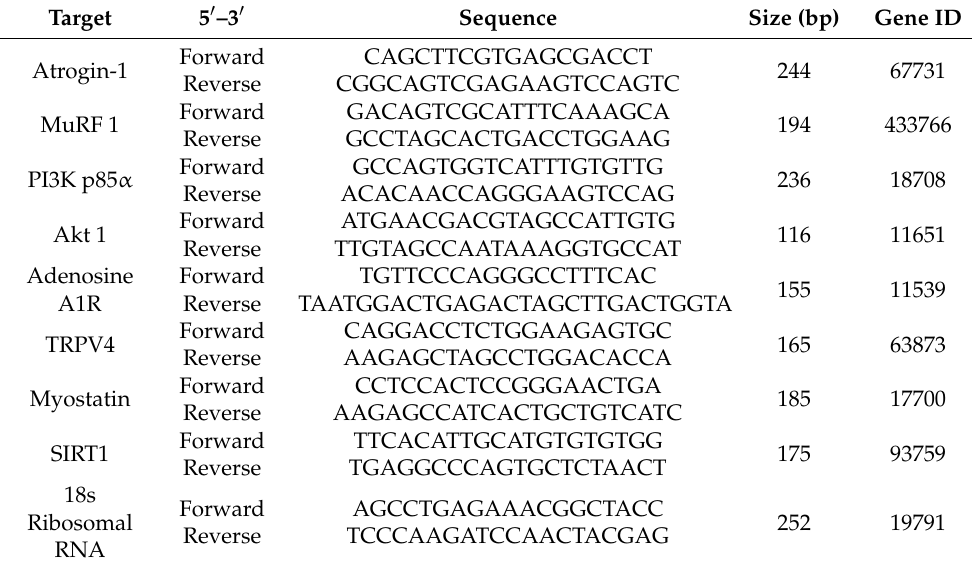
Table 1. Oligonucleotides for qRT-PCR used in this study.